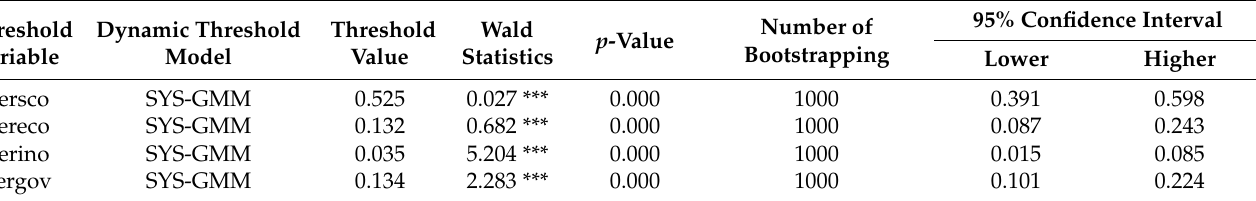
Table 9. The threshold value of four regime-switching variables and its confidence